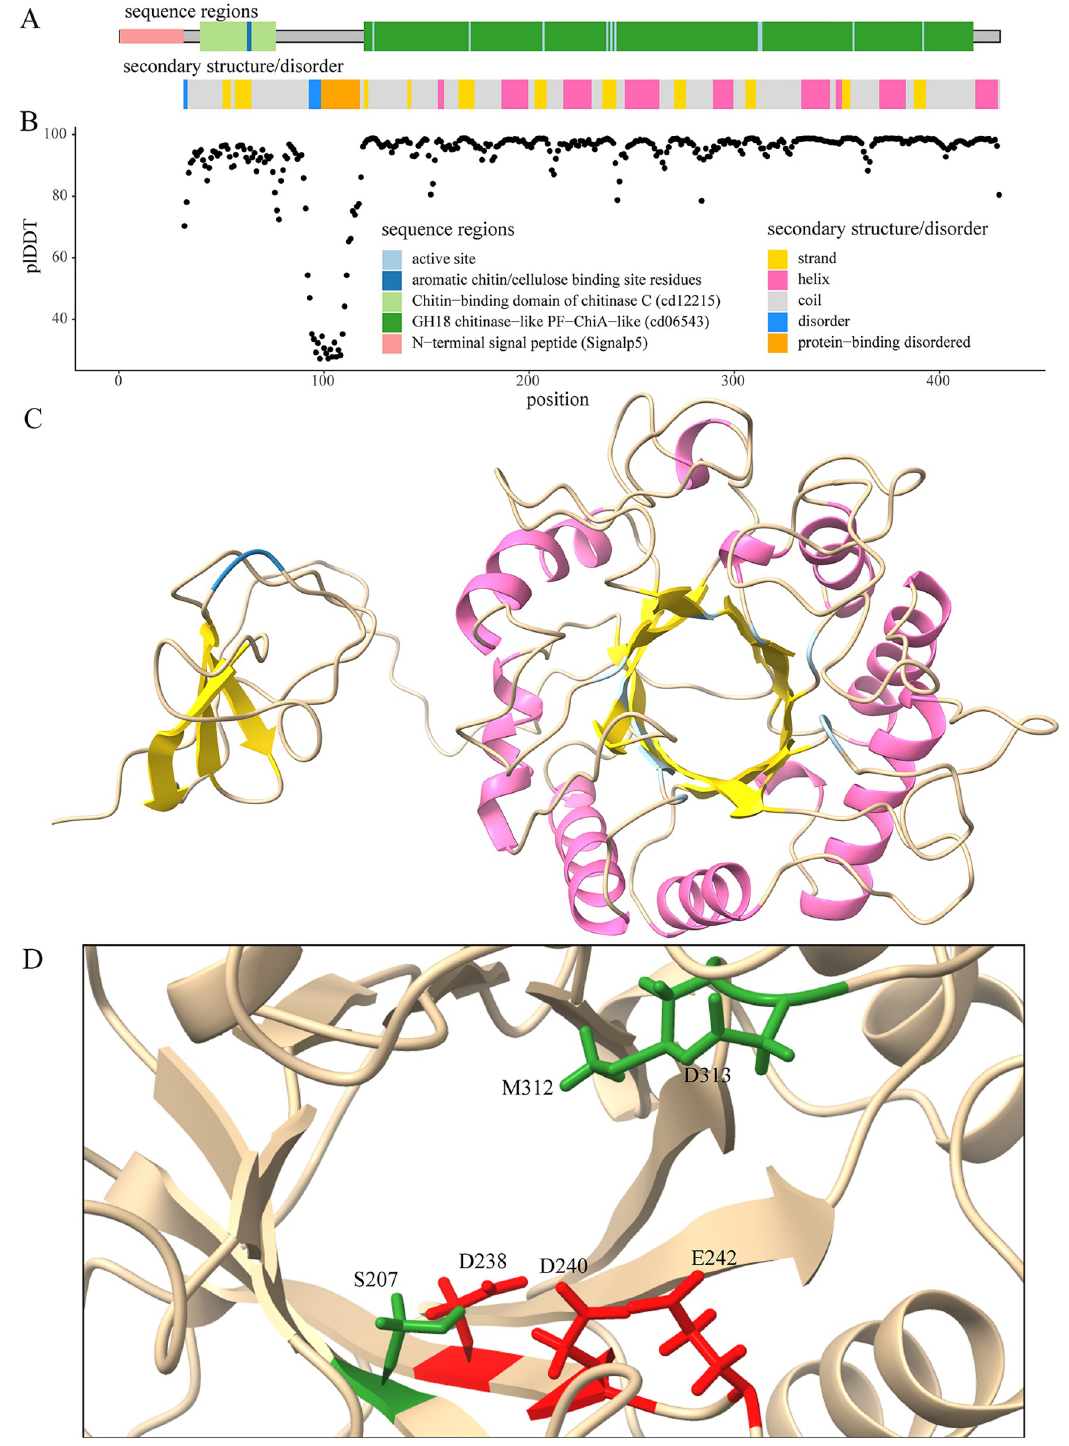
Fig 3. Structural characteristics of the Curtobacterium sp. GD1 429 amino acid chitinase protein. ( A ) Sequence region and secondary structure/disorder prediction. The protein contains a predicted 31 amino acid long N-terminal signal peptide, an N- terminal chitin binding domain (cd12215) followed by a linker and a long PF-ChiA chitinase-like domain (cd06543). In the chitin binding domain two aromatic residues (W63 and W64—numbering scheme includes the N-sp) responsible for chitin binding are shown in dark blue; In the chitinase-like domain nine regions made from ten amino acids which constitute the active site based on